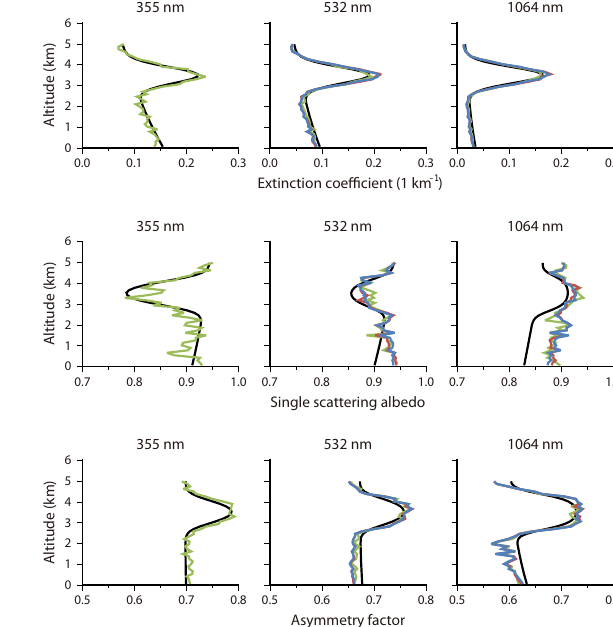
Figure 11. Figure 9 but showing the retrieval results from the sim- ulated data with random errors for the transported